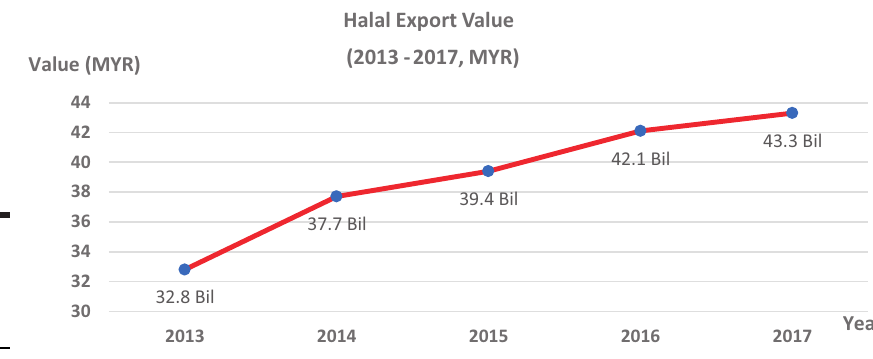
Figure 1. Halal export